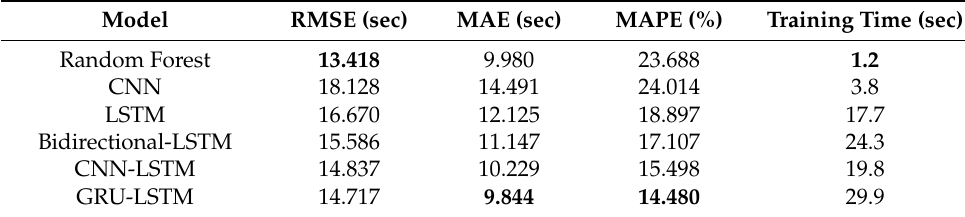
Table 2. Performance on dwell time